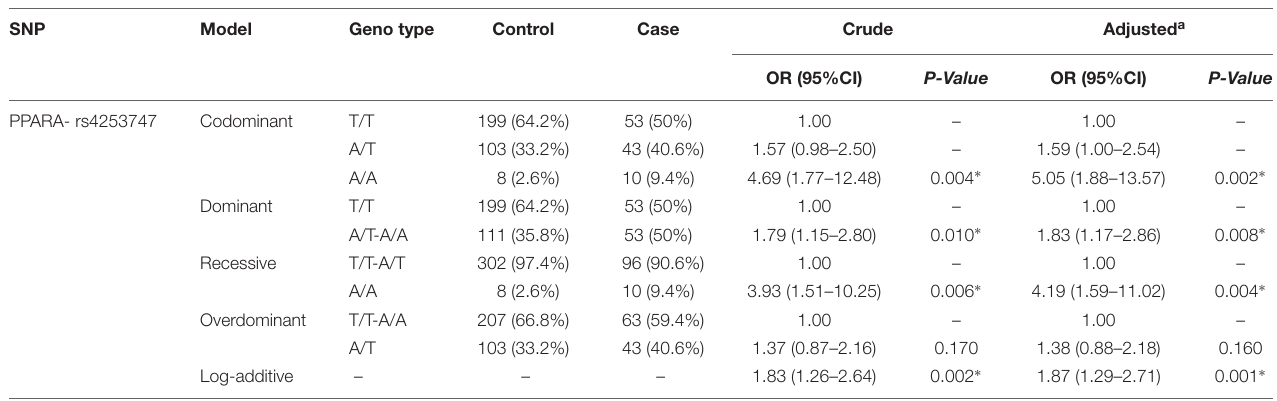
TABLE 3 | Single nucleotide polymorphism of rs4253747 analysis under different genetic models with the risk of HA appetite loss. SNP